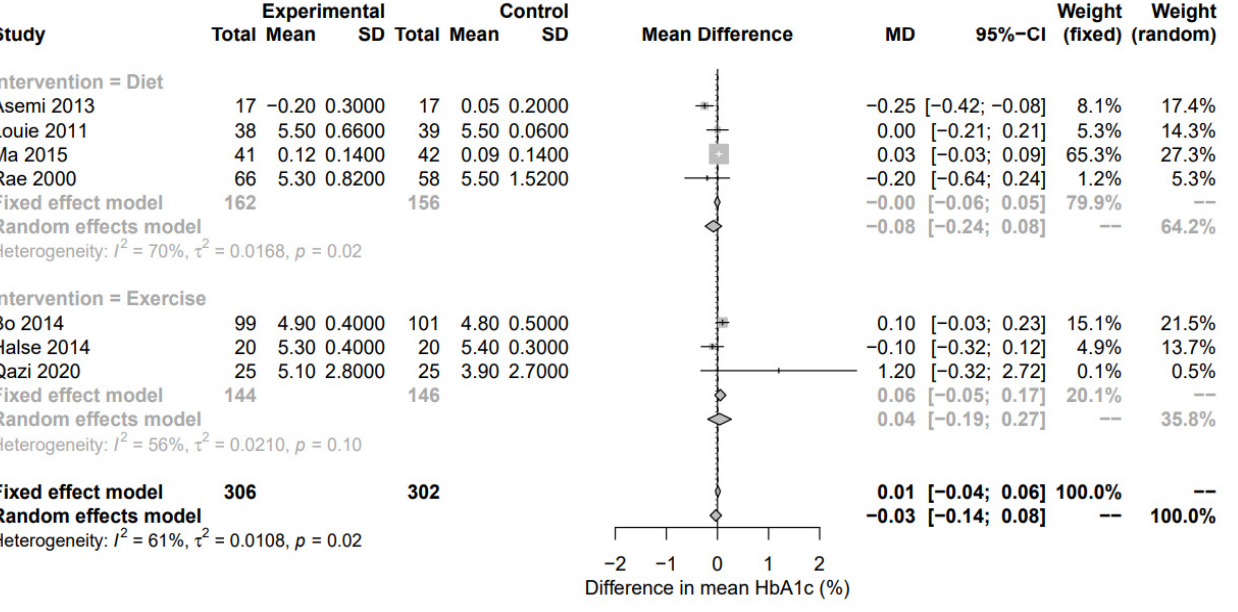
Figure 5. Forest plot of glycated hemoglobin (%). Fixed and random-effect meta-analysis of included studies. Overall test for effect of any lifestyle intervention (with all studies; n = 23) and subgroup analysis by intervention type—nutritional supplements (n = 8), diet (n = 10), and exercise (n = 5)—are presented. SD, standard deviation; CI, confidence interval.